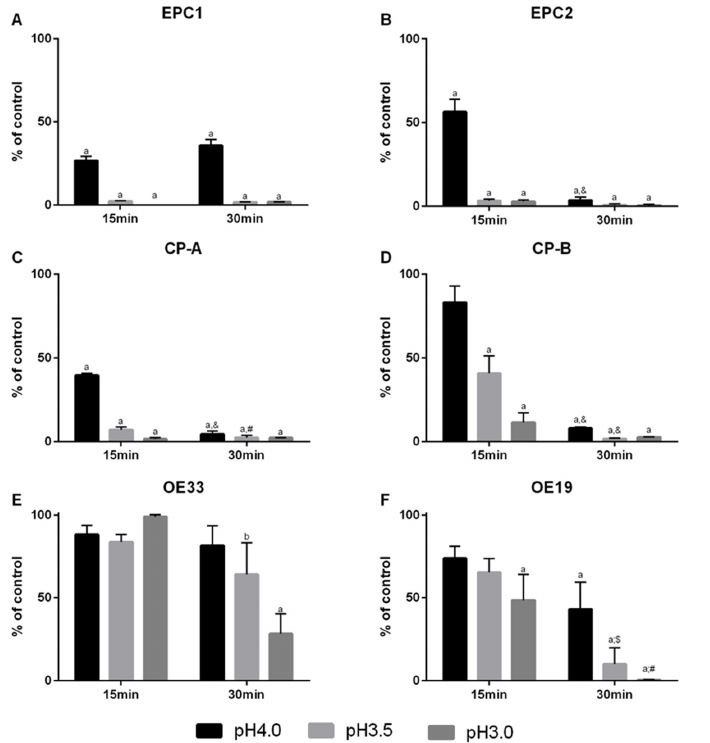
Figure 2 . Acid susceptibility in a Barrett’s esophagus cell culture model. Esophageal squamous epithelium cell lines EPC1 ( A ), EPC2 ( B ); Barrett’s metaplasia cell line CP-A ( C ), Barrett’s high-grade dysplasia cell line CP-B ( D ), and esophageal adenocarcinoma cell lines OE33 ( E ) and OE19 ( F ) were exposed to acidified media with pH 4, pH 3.5, or pH 3 for 15 and 30 min. Full growth medium (pH 7.4) served as controls. Viability was measured photometrically by PrestoBlue Cell Via- bility Reagent stain. Values are shown as mean ± S.E.M. (Two-way ANOVA with Sidak’s multiple comparisons test; a— p < 0.001, b— p < 0.01 compared to control; &— p < 0.001, $— p < 0.01, #— p < 0.05, compared to 15